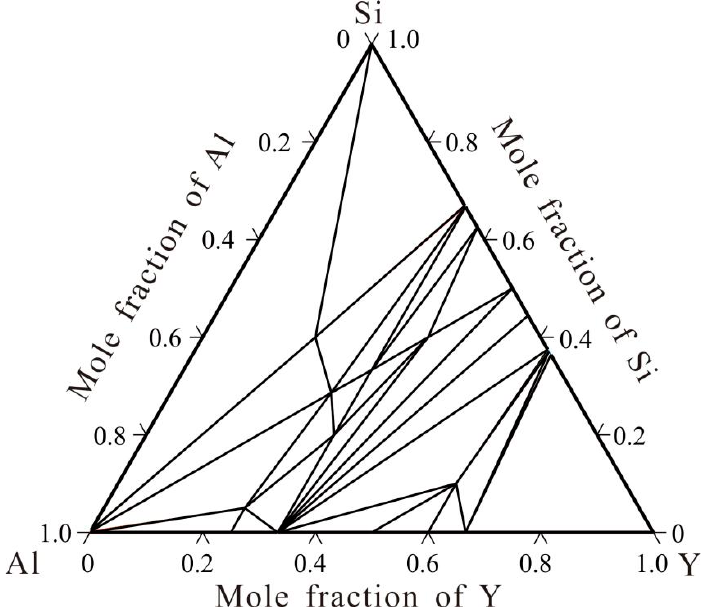
Figure 2. Calculated isothermal section of the Al–Si–Y system at 773 K.